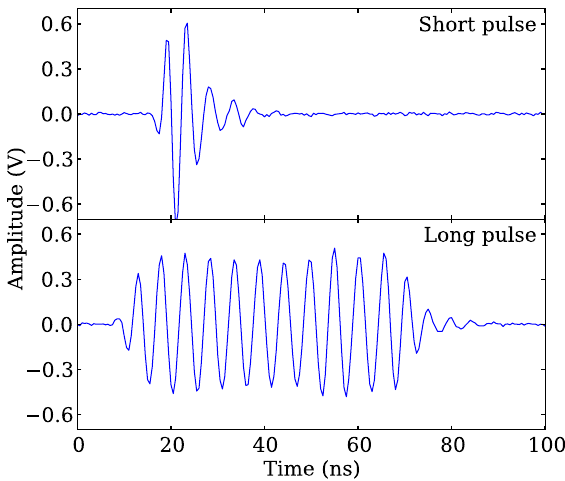
FIG. 6. Example digitized signals from the horizontal position channel of the cavity BPM excited by a short beam pulse and a long